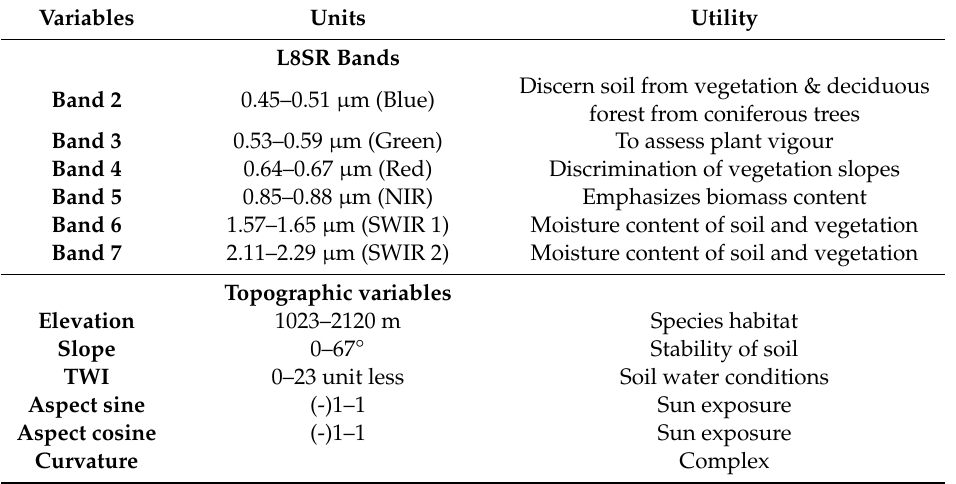
Table 1. Image and raster data from Landsat TM and ASTER-DEM to use as predictor variables.